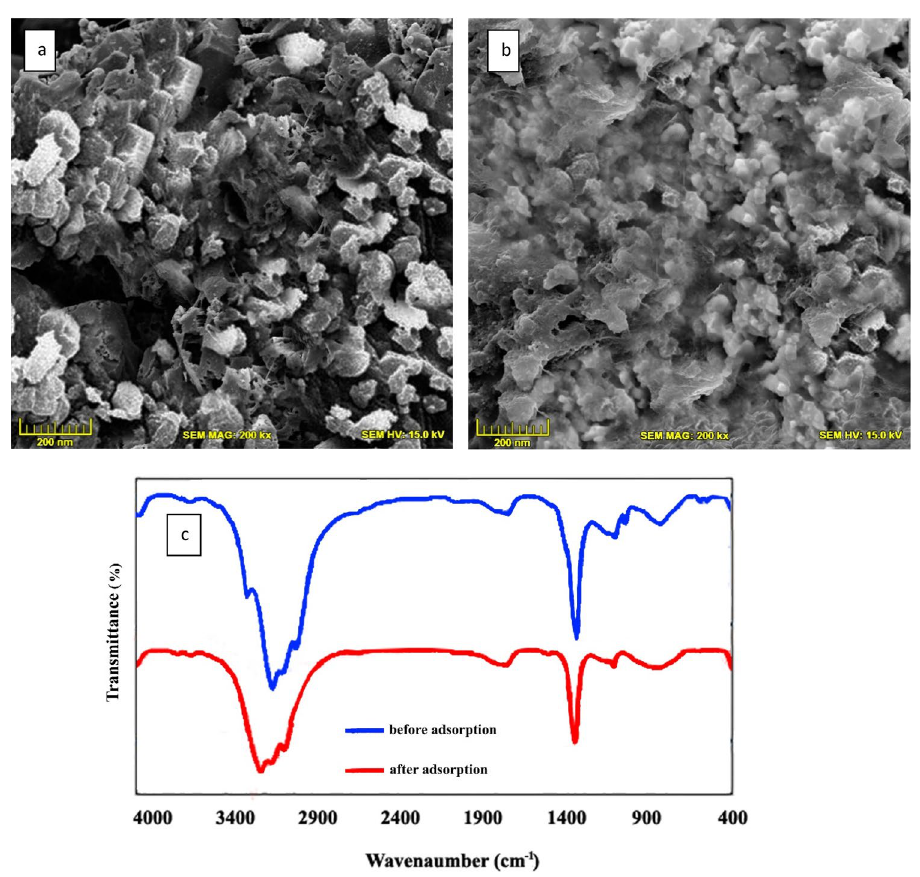
Figure 1. SEM images of bivalve shell before ( a ) and after adsorption ( b ) and FT-IR analysis ( c ) of adsorbents.